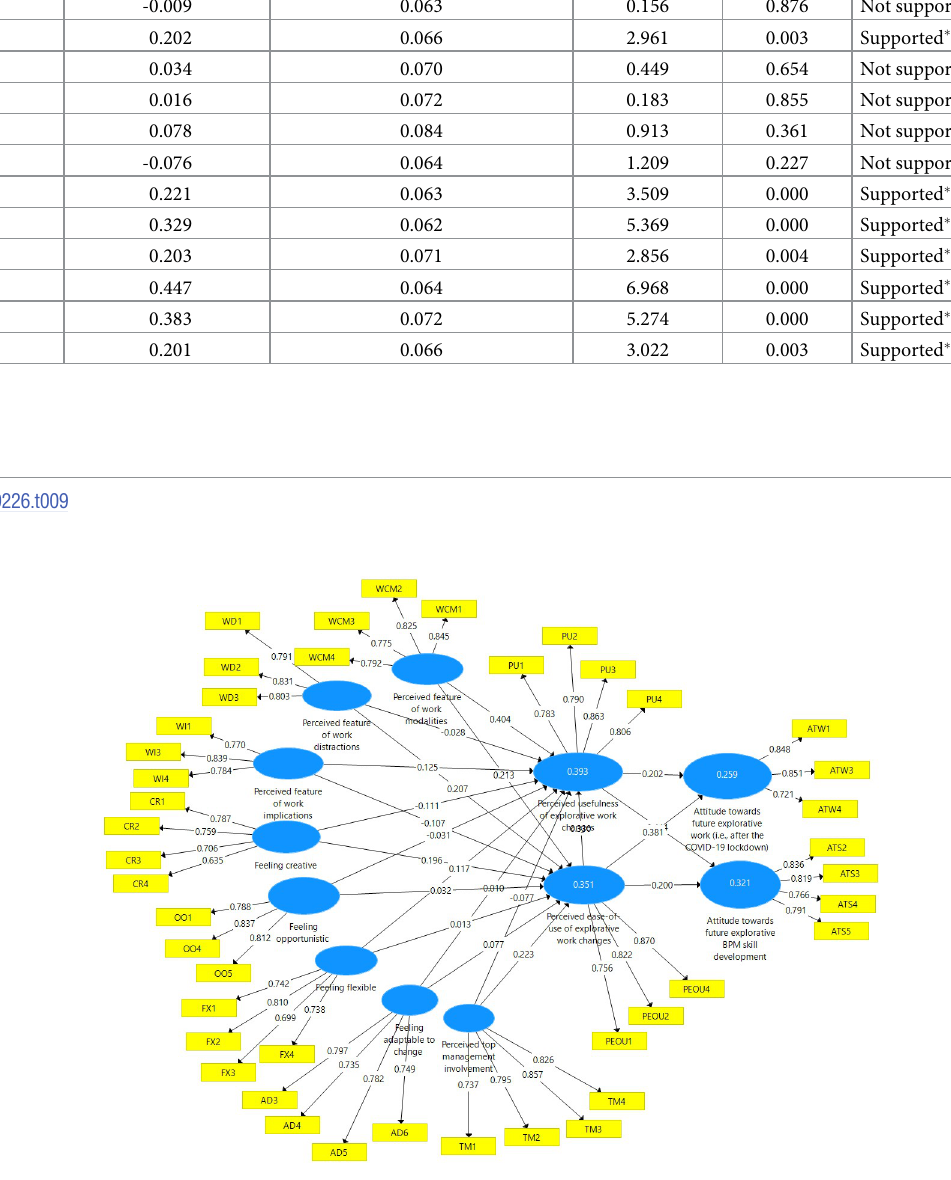
Fig 2. The PLS algorithm output of the explorative BPM acceptance